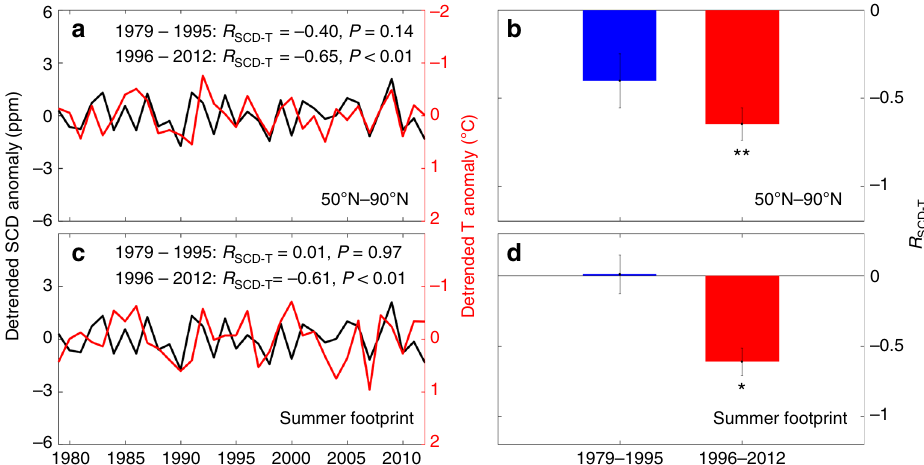
Fig. 1 Negative temperature control of summer CO 2 drawdown. a – d Time series of anomalies of summer CO 2 drawdown (SCD, black line) and summer temperature (T, red line) calculated as the average for July and August across ecosystems north of 50°N ( a ), the spatial average weighted by the potential emission sensitivities from FLEXPART over the vegetated land area within the multi-year mean summer footprint ( c ), The comparison of interannual partial-correlation coef fi cient between SCD and T ( R SCD-T ) between the two periods (1979 – 1995 and 1996 – 2012) based on north of 50°N and summer footprint, respectively b and d . The interannual partial-correlation coef fi cient is calculated by statistically controlling for the effects of summer precipitation and cloudiness. We calculate R SCD-T through randomly selecting 14 of the 17 years in each corresponding period, and then take their standard deviation as the error bar. All variables were detrended for each period before the partial-correlation analysis. * and ** indicate that the partial-correlation coef fi cient is signi fi cant at P < 0.05 and P < 0.01, respectively. The fi gure was created using Matlab